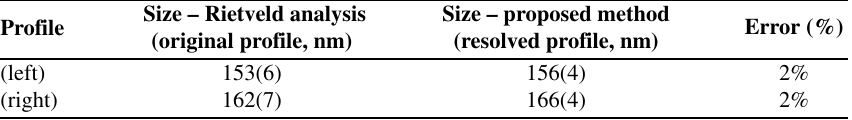
Table 2. Calculated crystallite sizes obtained by this method and comparison to those obtained by Rietveld analysis for the real samples.